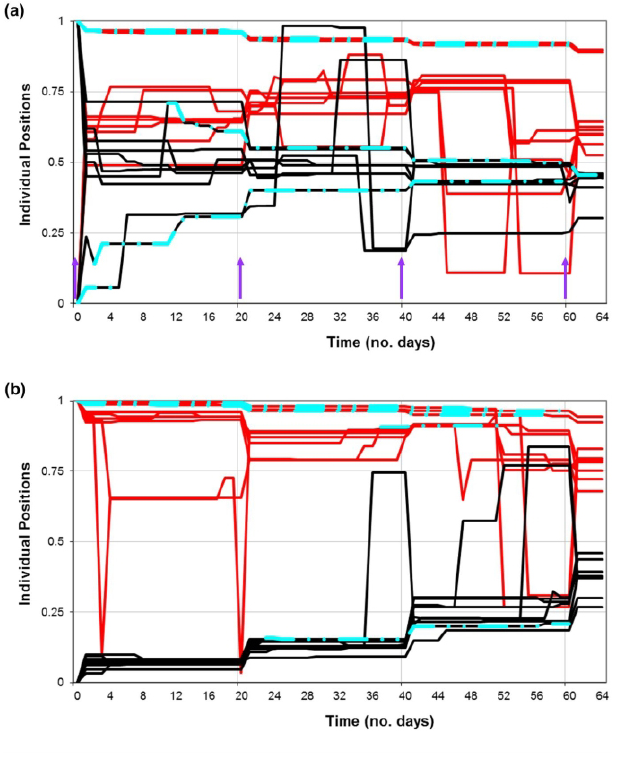
Fig. 11 . Evolution of individual positions in two groups across polarization scenarios with cost of dissent and entrenchment with a 10% mutation rate: (a) intragroup polarization and (b) intergroup polarization. Turquoise dotted-line overlay indicates duration of agent entrenchment. Solid arrows show formal interactions (Note: only some meetings are